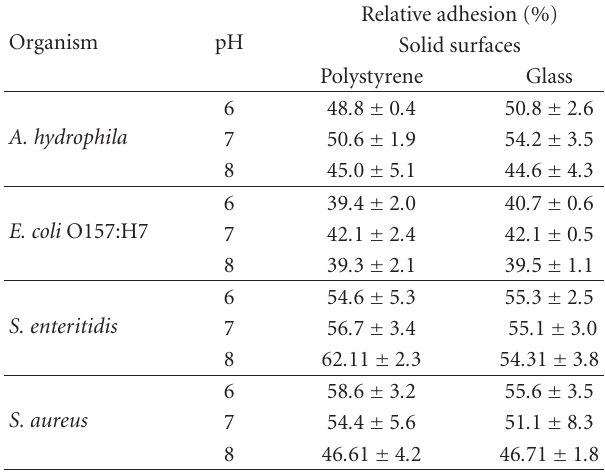
Table 3: E ff ect of culture pH on the adhesion of pathogenic bacteria to polystyrene and